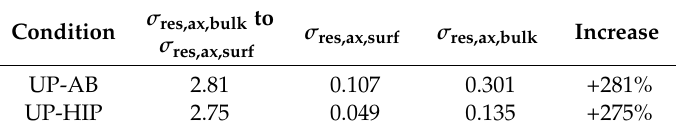
Figure 7. Normalized in-depth axial residual stress progression of AB and HIP conditions. Table 4. Axial in-depth residual stress measurement